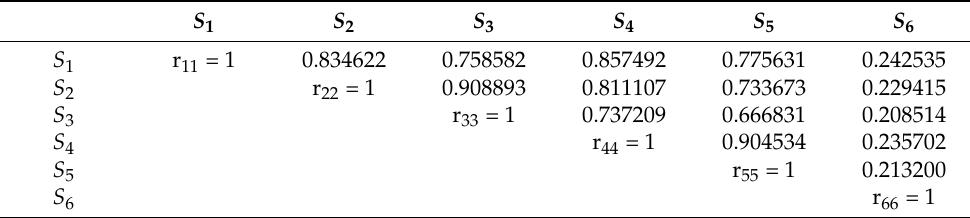
Figure 5. Results for the stochastic parameters’ mathematical expectation ( E ), variance ( D ) and standard deviation ( sigma ). Table 1. Experimental estimates of the correlation between defined pathways.